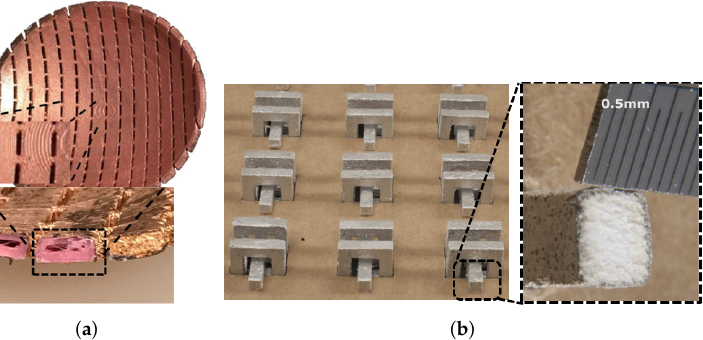
Figure 4. Examples of 3-D metamaterials manufactured by 3-D printing with subsequent metalliza- tion. ( a ) Design from [178] fabricated using FDM and electroplating. ( b ) Design from [135] fabricated using MJ and silver coating.